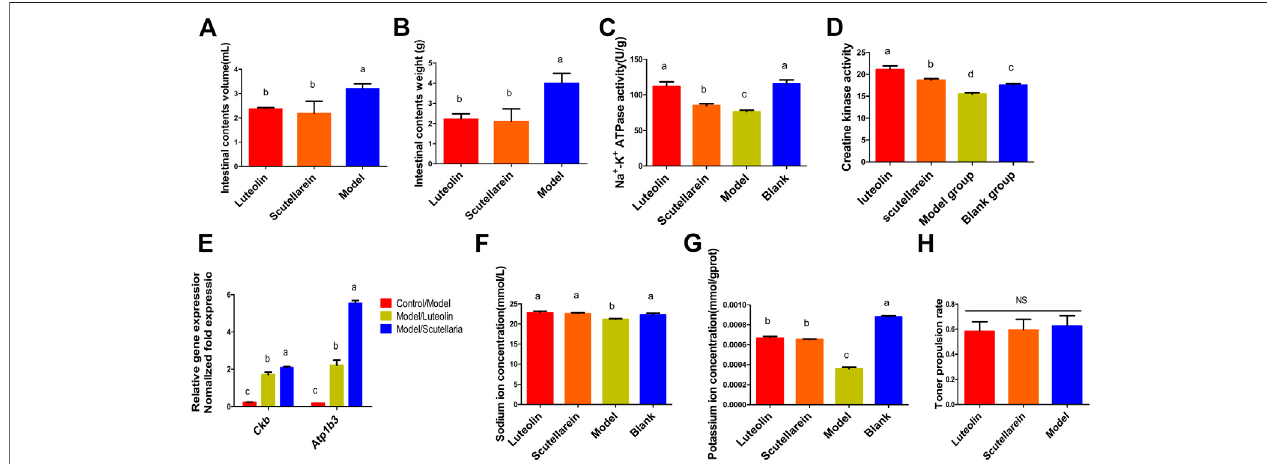
FIGURE 4 | Analysis of antidiarrhea mechanism of the effective components of Plantago asiatica L. (A,B) Castor oil-induced intestinal fl uid accumulation. (C,D) Changes in Na + /K + -ATPase and creatine kinase activities in the small intestine of rats. (E) The quantitative PCR. Relative gene expression > 1 represents upregulating gene. In contrast, relative gene expression < 1 represents a downregulating gene. (F – G) Changes in sodium and potassium ion concentrations in the small intestine of rats. (H) Charcoal meal model of intestinal motility. Data are presented as the means ± SD from fi ve groups. Different small letter superscripts in the same column indicate signi fi cant differences at p < 0.05. NS indicates no signi fi cant